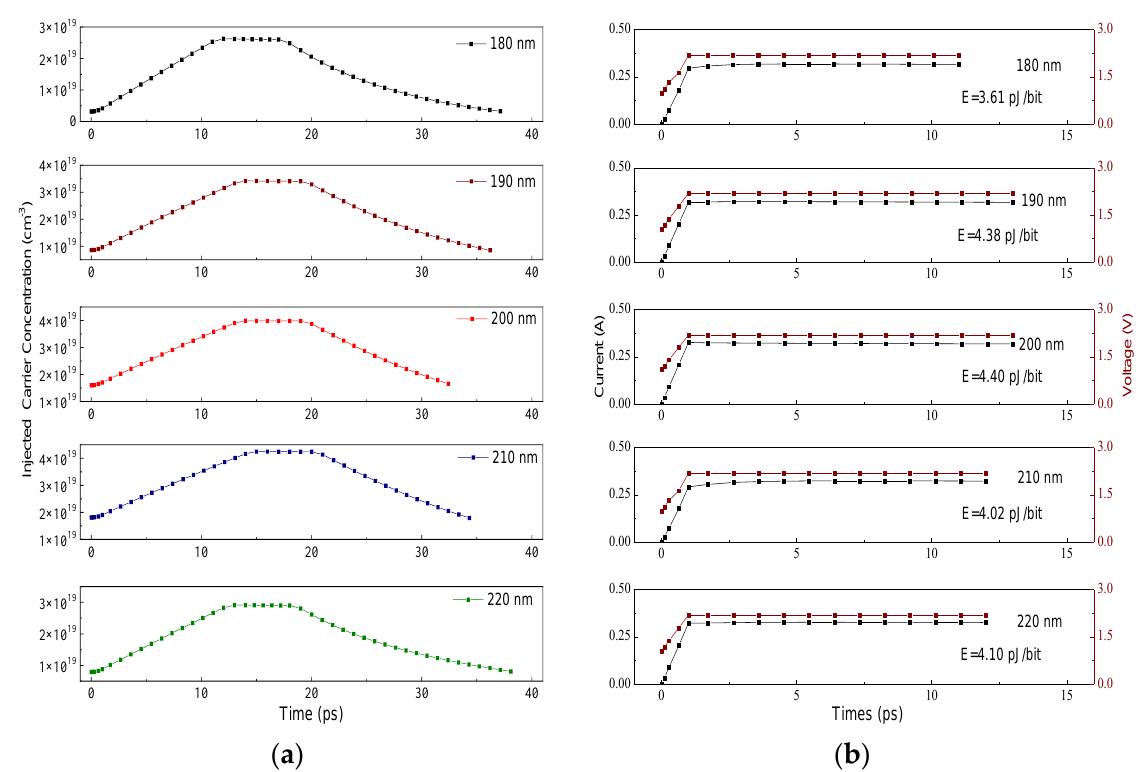
Figure 9. ( a ) The change of carrier concentration with time for different widths of CIPMRMs; ( b ) the VI-t curve for different widths of CIPMRMs. Table 2. The performance of CIPMRMs for different line widths.